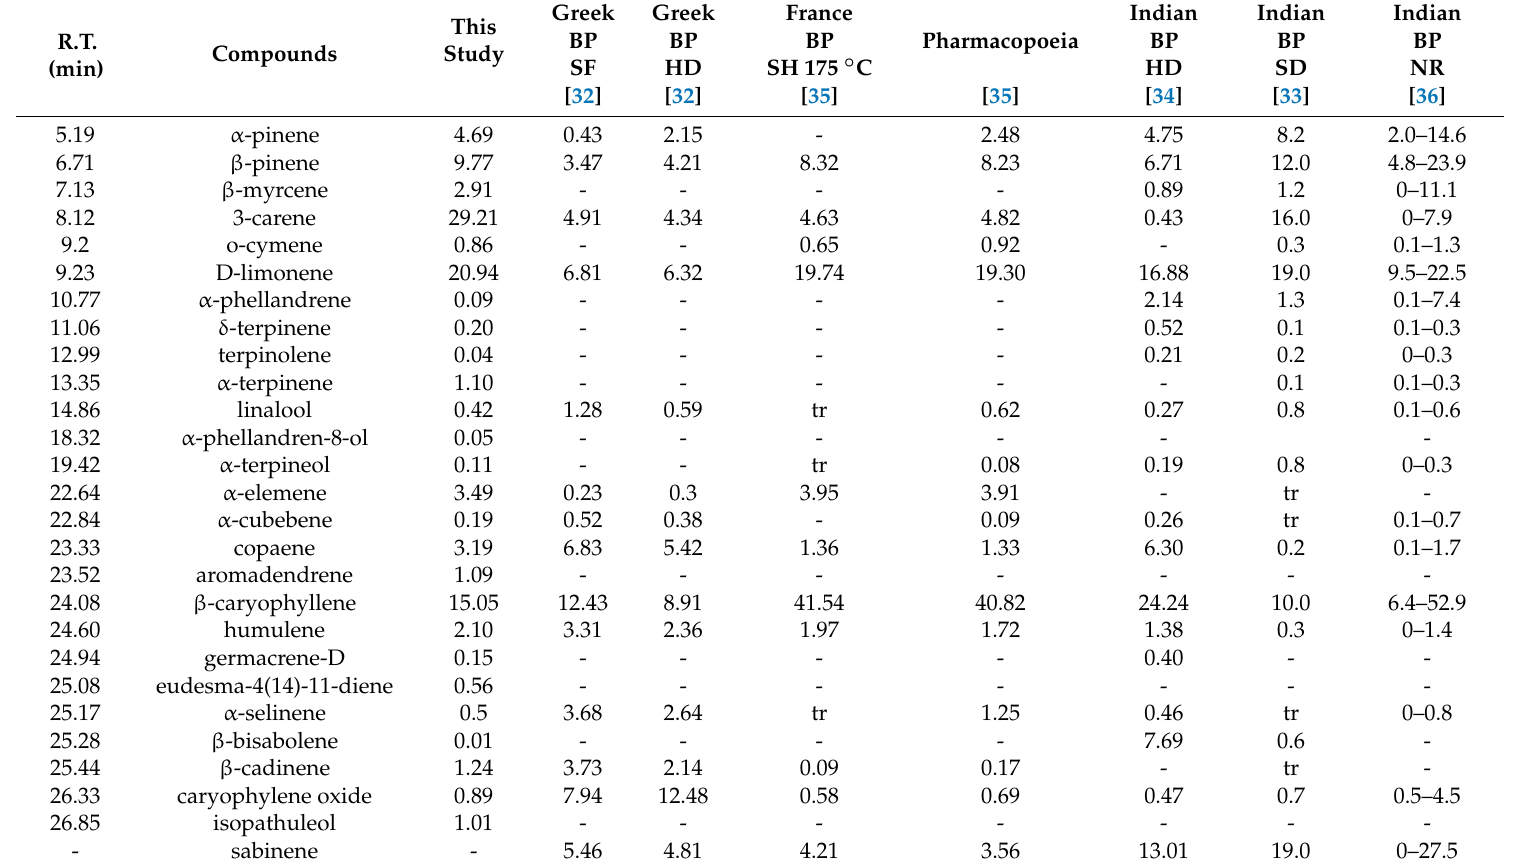
Table 5. A comparison with regard to the method of